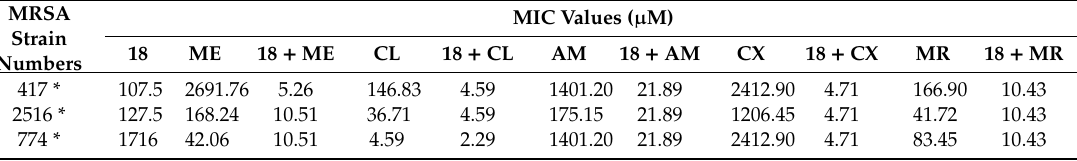
Table 2. Combination studies of benzamide 18 with diverse β -lactam